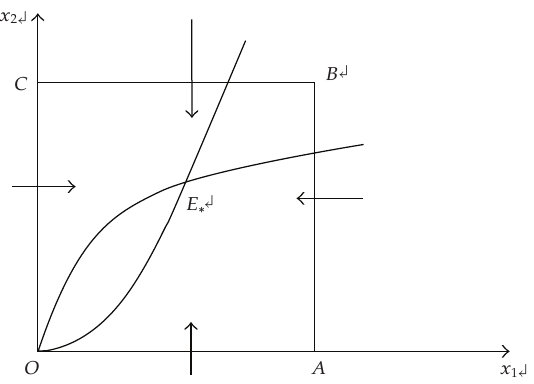
Figure 1: Trajectories enter rectangle OABCO from exterior to